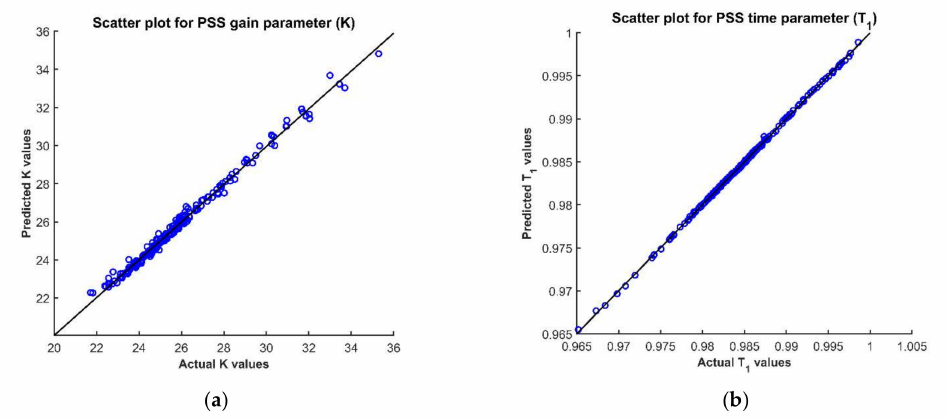
Figure 10. Scatter plots for the PSS key parameters of the second network test datasets; ( a ) PSS gain parameter ( K ) and ( b ) PSS time constant parameter ( T 1